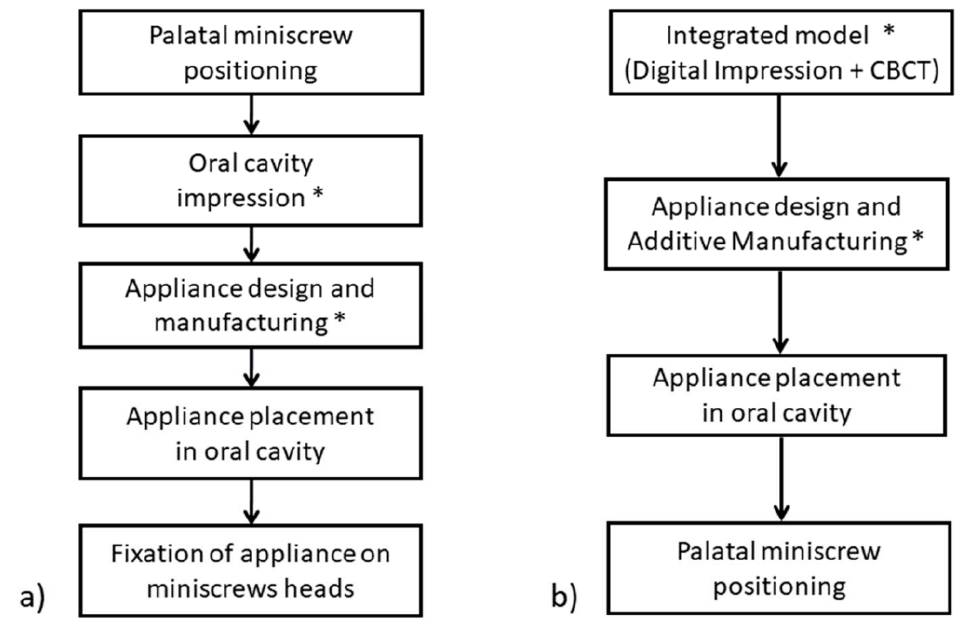
Figure 2. Conventional ( a ) vs. DIVA ( b ) workflow. The * symbol indicates a step performed with digital technology.